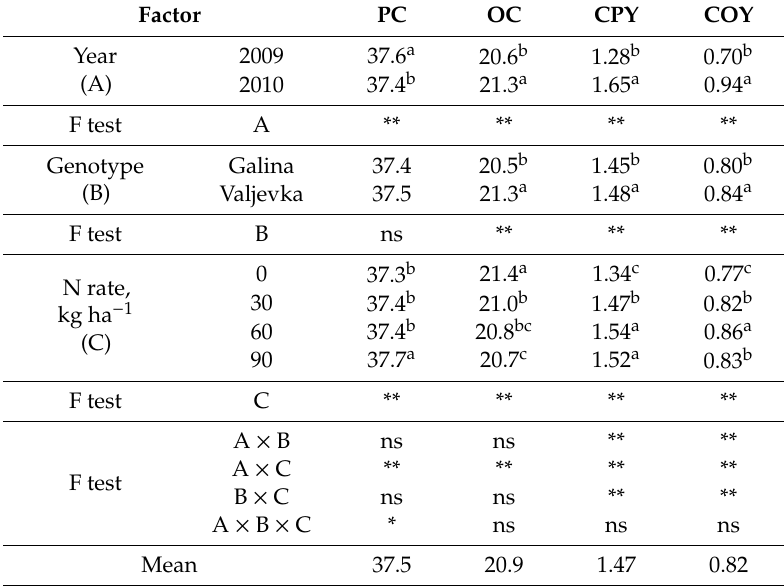
Table 2. Year, genotype and N rate e ff ects on qualitative parameters, protein, and oil yield.